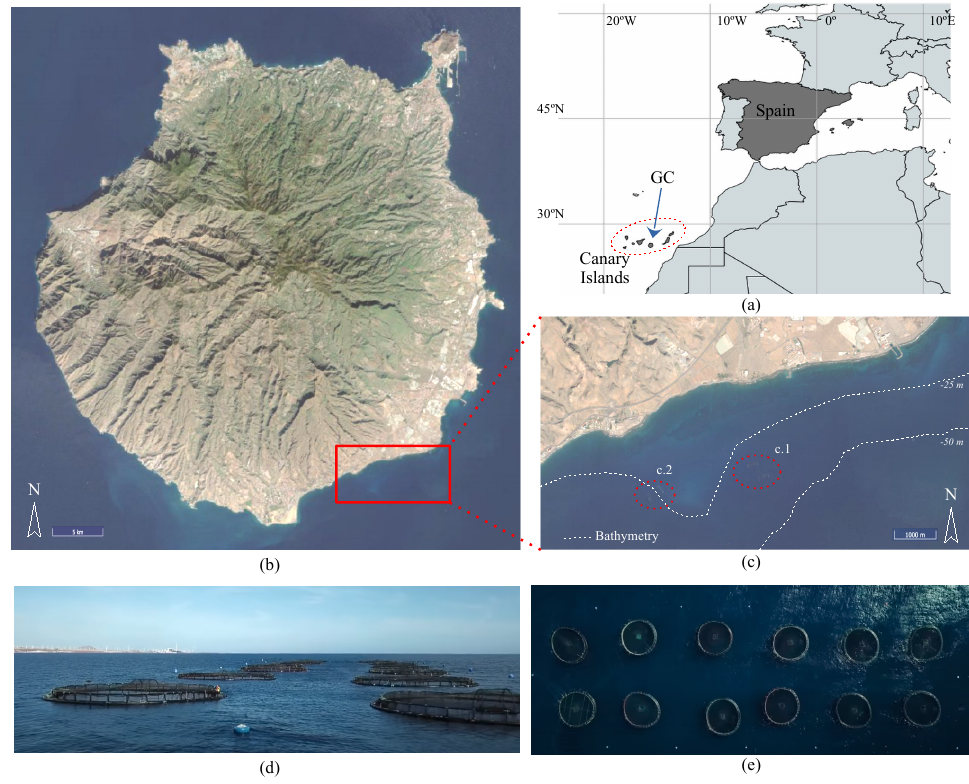
Figure 7. The study location that was used to evaluate the proposed MU: ( a ) a map of the Canary Islands in the Atlantic Ocean; ( b , c ) the satellite photos of Gran Canaria and the location of the offshore aquaculture facility in the south of GC ((c.1) the Aquanaria S.L. facility; (c.2) anther offshore aquaculture infrastructure), respectively; ( d ) a lateral view and ( e ) a top view of one of the 2 × 6 cage structure arrays that were used in our experiments.